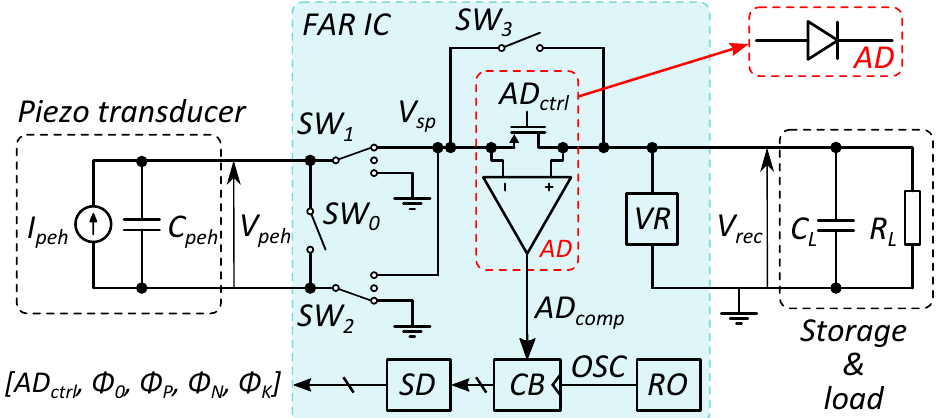
Figure 2. Full Active Rectifier (FAR) IC architecture Wassouf et al. [24].